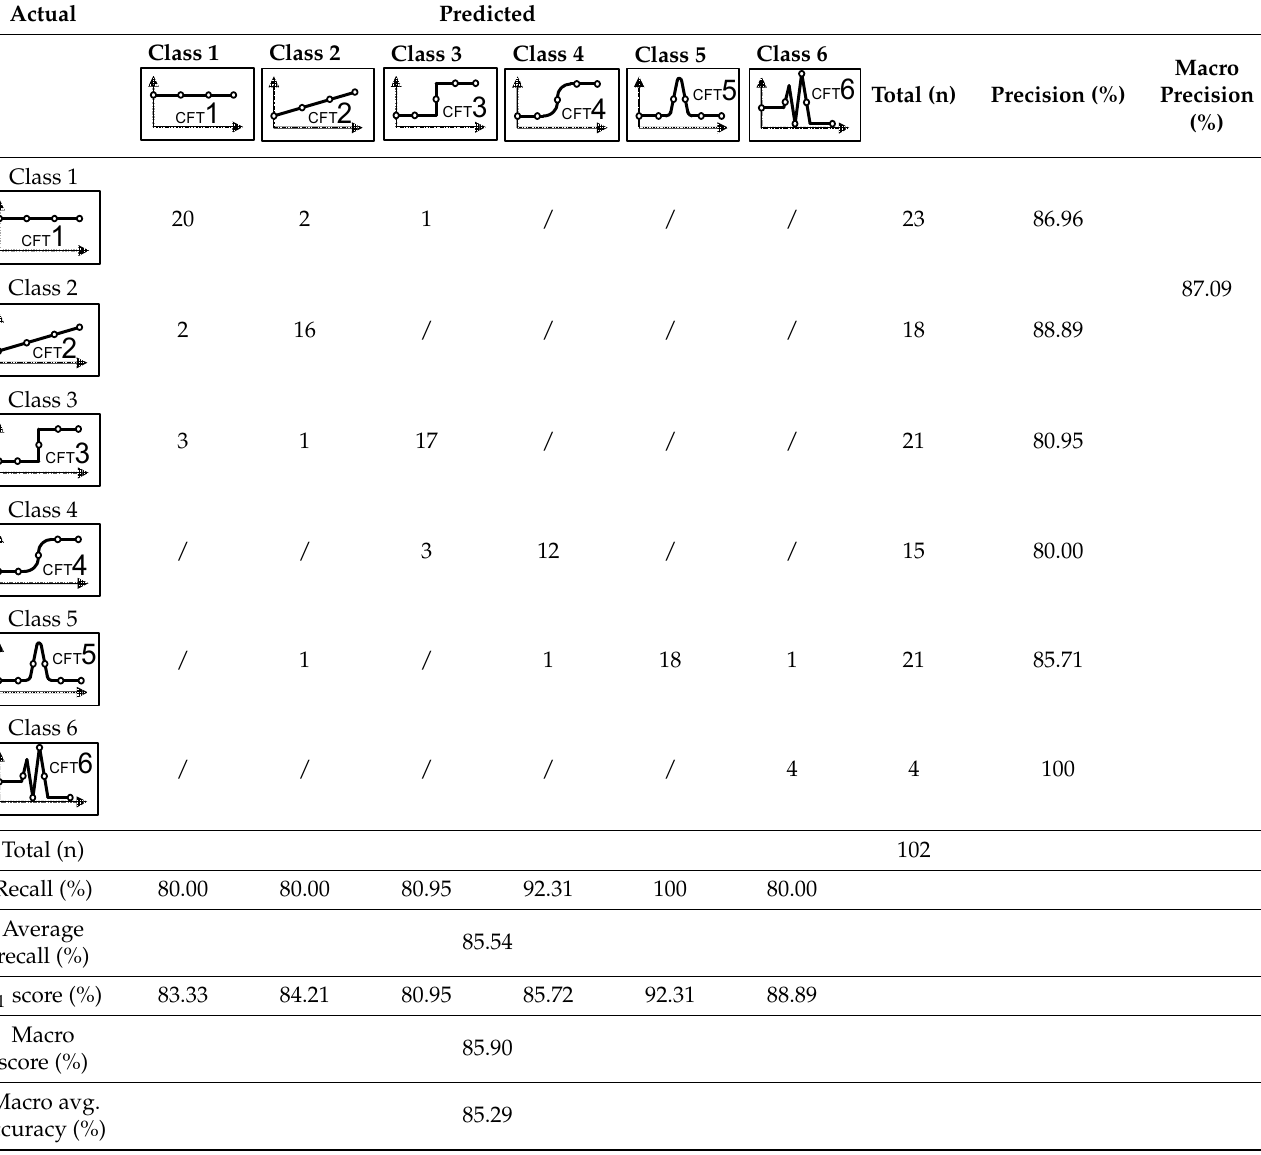
Table 1. Confusion matrix for the cutting force trend classification.